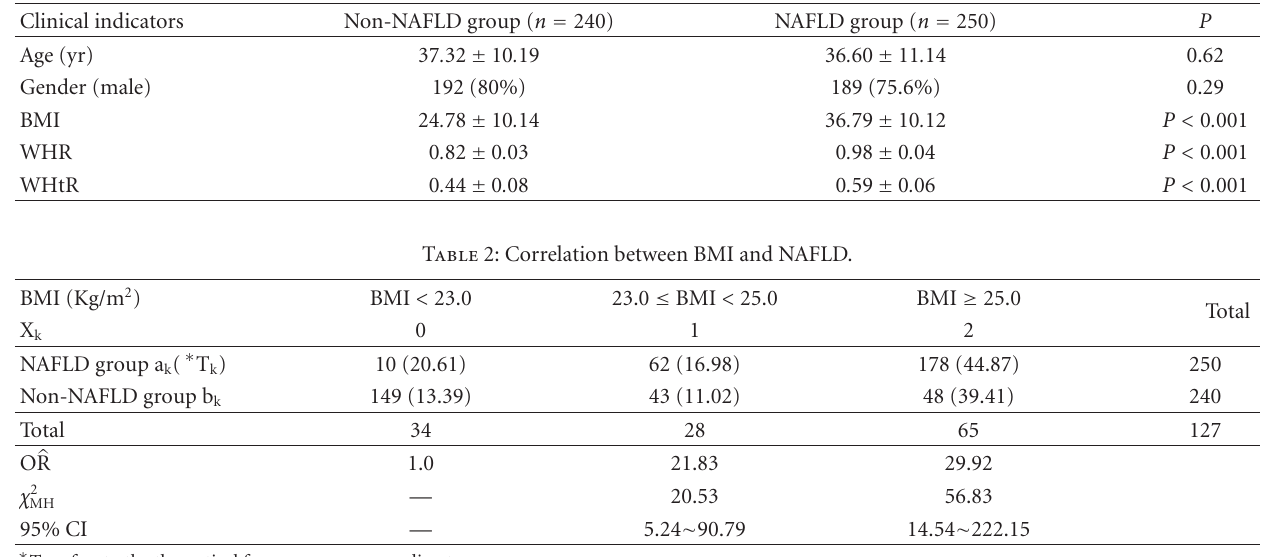
Table 1: Gender, age and anthropometric indicators in NAFLD group and non-NAFLD group ( x ± s ).